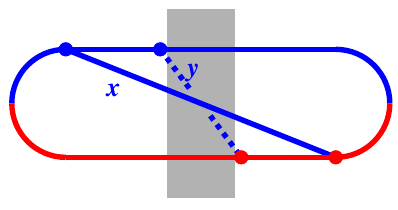
Figure 3 . One diagrammatic contribution [16] to the rate for double splitting, such as g → ggg